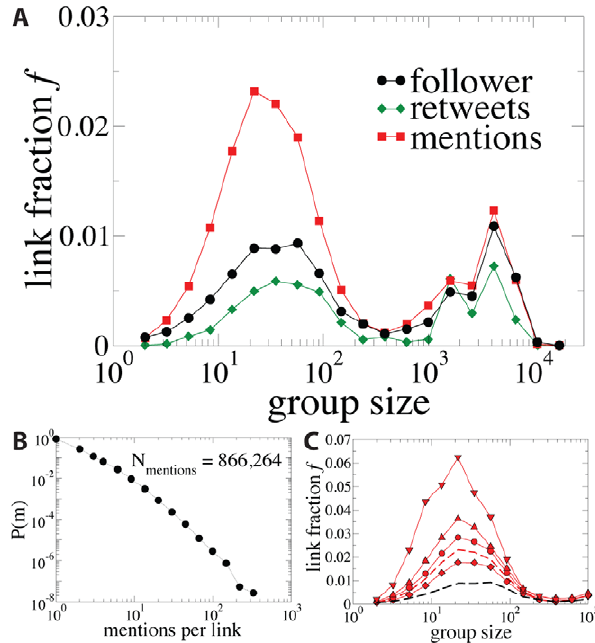
Figure 3. Internal activity. (A) Fraction f of internal links as a function of the group size in number of users. The curve for the follower network acts as baseline for mentions and retweets. Note that if mentions/retweets were randomly appearing over follower links then the red/green curve should match the black curve. (B) Distribution of the number of mentions per link. (C) Fraction of links with mentions as a function of their intensity. The dashed curves are the total for the follower network (black) and for the links with mentions (red). While the other curves correspond (from bottom to top) to fractions of links with: 1 non-reciprocated mention (diamonds), 3 mentions (circles), 6 mentions (triangle up) and more than 6 reciprocated mentions (triangle